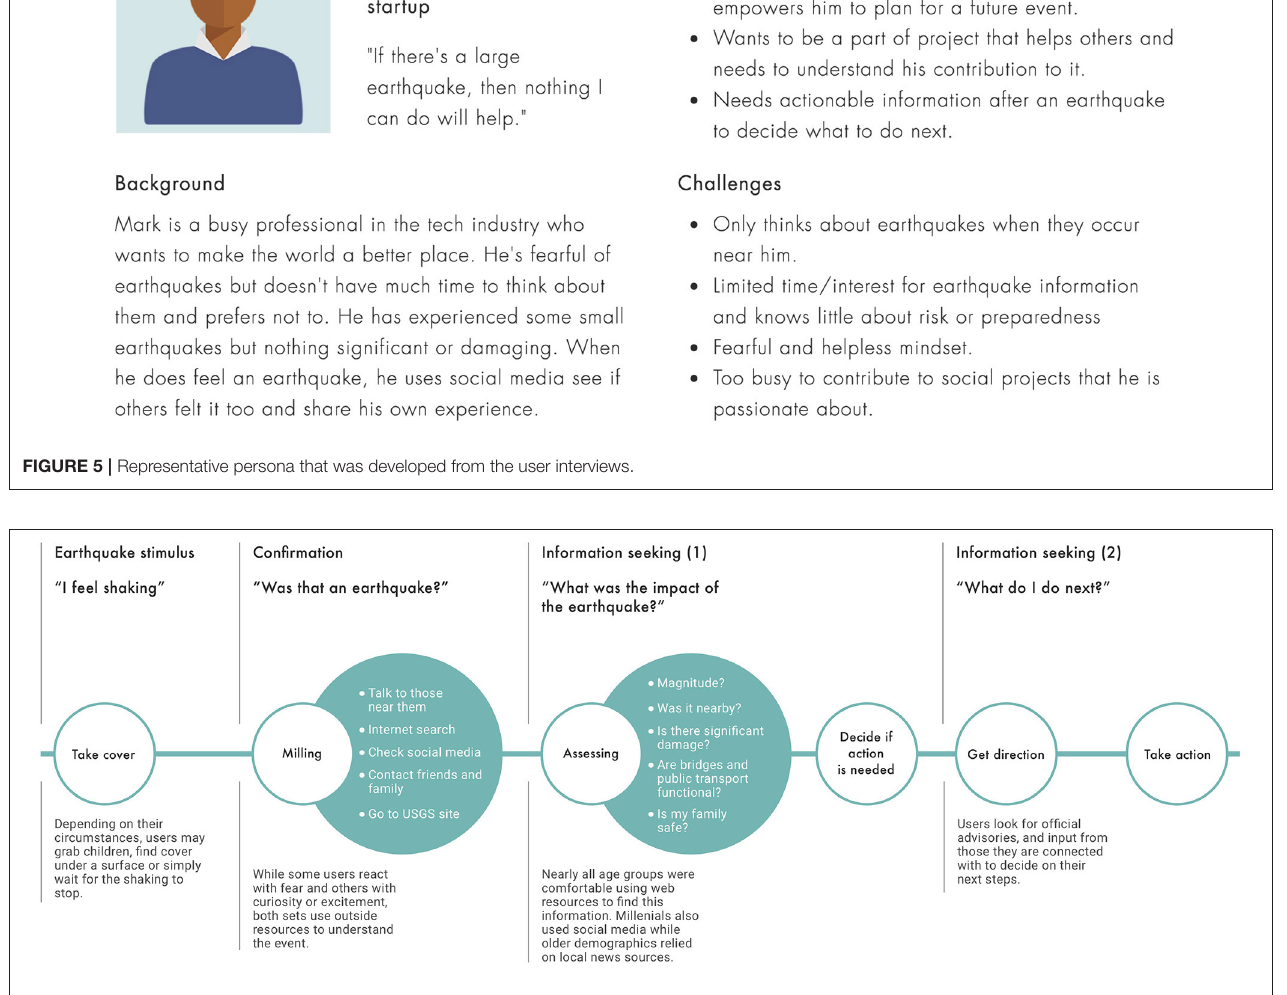
FIGURE 6 | Task analysis infographic depicting the four distinct action types personas engage in after an earthquake event.